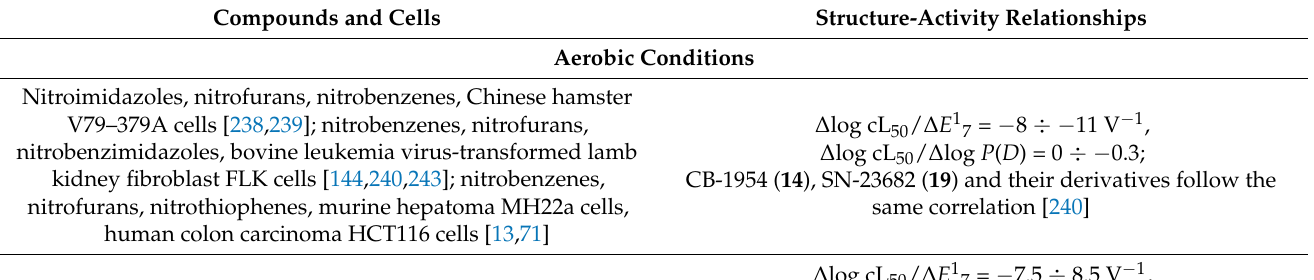
Table 4. Structure-activity relationships in mammalian cell cytotoxicity of nitroaromatics with possible relevance to bioreductive